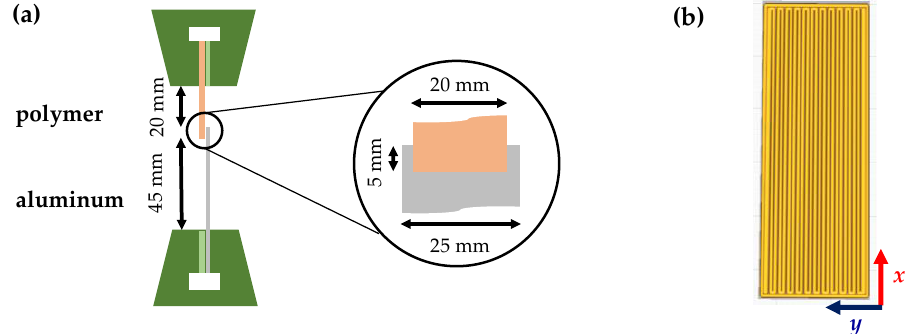
Figure 4. ( a ) Schematic test setup—tensile single lap shear strength; ( b ) ME buildup strategy of the polymer part.